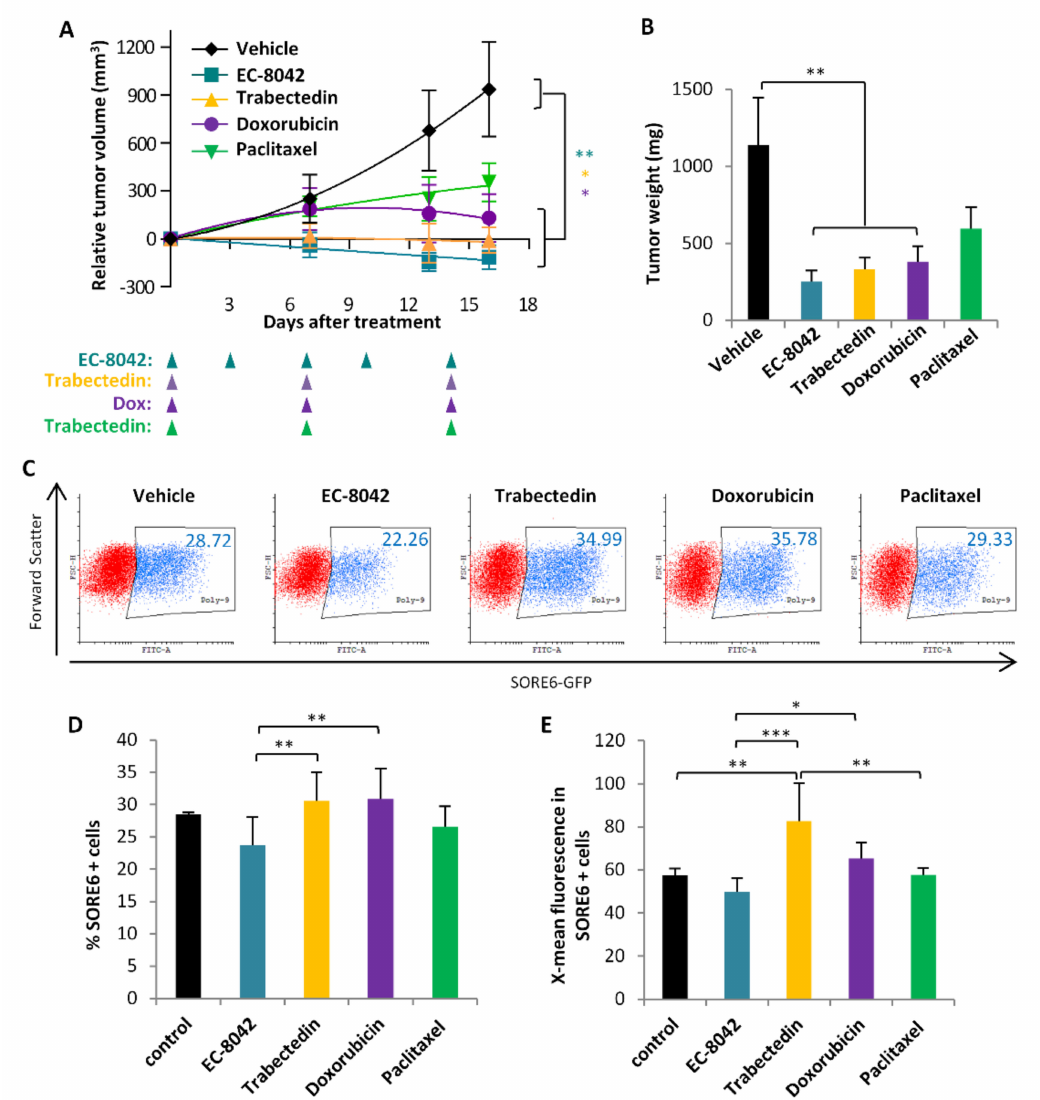
Figure 7. Evaluation of SORE6 activity after in vivo treatments. Mice with tumor xenografts established after the s.c. inoculation of 3 × 10 6 T-5H-O-SORE6-GFP cells were randomly assigned to 5 di ff erent groups ( n = 5 per group) and treated i.v. with saline bu ff er (control), EC-8042 (18 mg / Kg; every 3 / 4 days up to 5 doses), trabectedin (0.15 mg / Kg; every 7 days up to 3 doses), doxorubicin (4 mg / Kg; every 7 days up to 3 doses) or paclitaxel (20 mg / Kg; every 7 days up to 3 doses). ( A ) Curves representing the mean relative tumor volume ( ± SEM) of xenografts during the treatments. The timing of treatments is indicated, all mice received the last treatment on day 14 and tumors were extracted and analyzed on day 16. ( B ) Mean tumor weight ( ± SEM) at the end of the experiment. Asterisks indicate significantly di ff erent kinetics than the control series (*: p < 0.05, **: p < 0.005; one-way ANOVA). ( C , D ) Flow cytometry analysis of SORE6 activity in tumors collected and disaggregated 48 h after the last dose of the indicated treatments. Representative flow cytometry dot plots ( C ) and summary graphs representing the percentage of SORE6 + cells (mean ± standard deviation) ( D ) and the mean SORE-GFP fluorescence intensity (mean ± standard deviation) ( E ) are shown. Asterisks indicate statistically significant di ff erences between series (*: p < 0.05, **: p < 0.005, ***: p < 0.0005; one-way